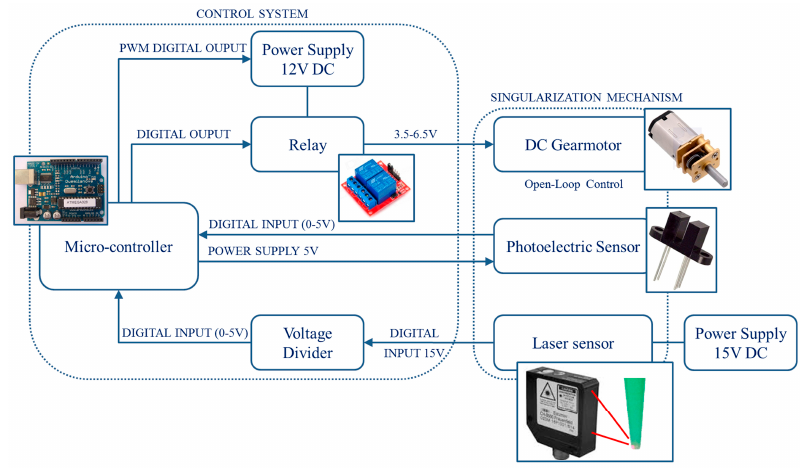
Figure 5. Block diagram of the experimental setup.